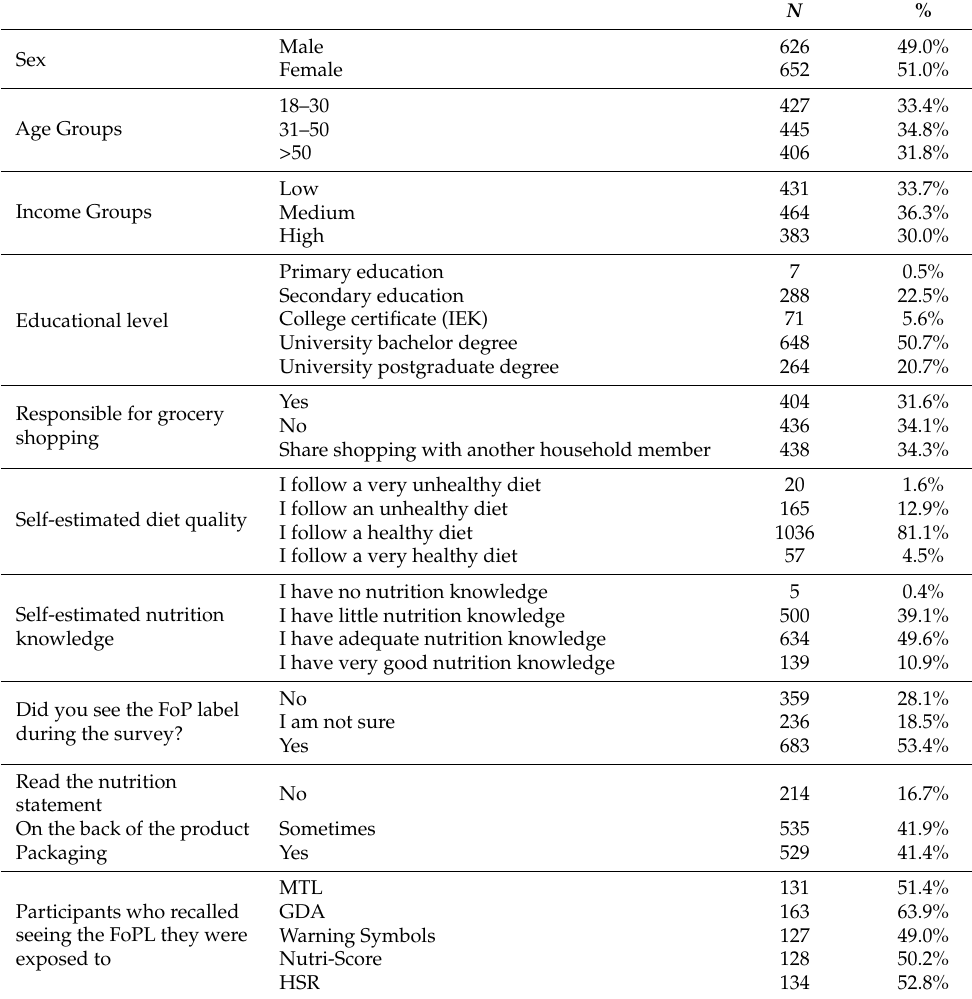
Table 1. Individual characteristics of the study sample from Greece ( N = 1278).